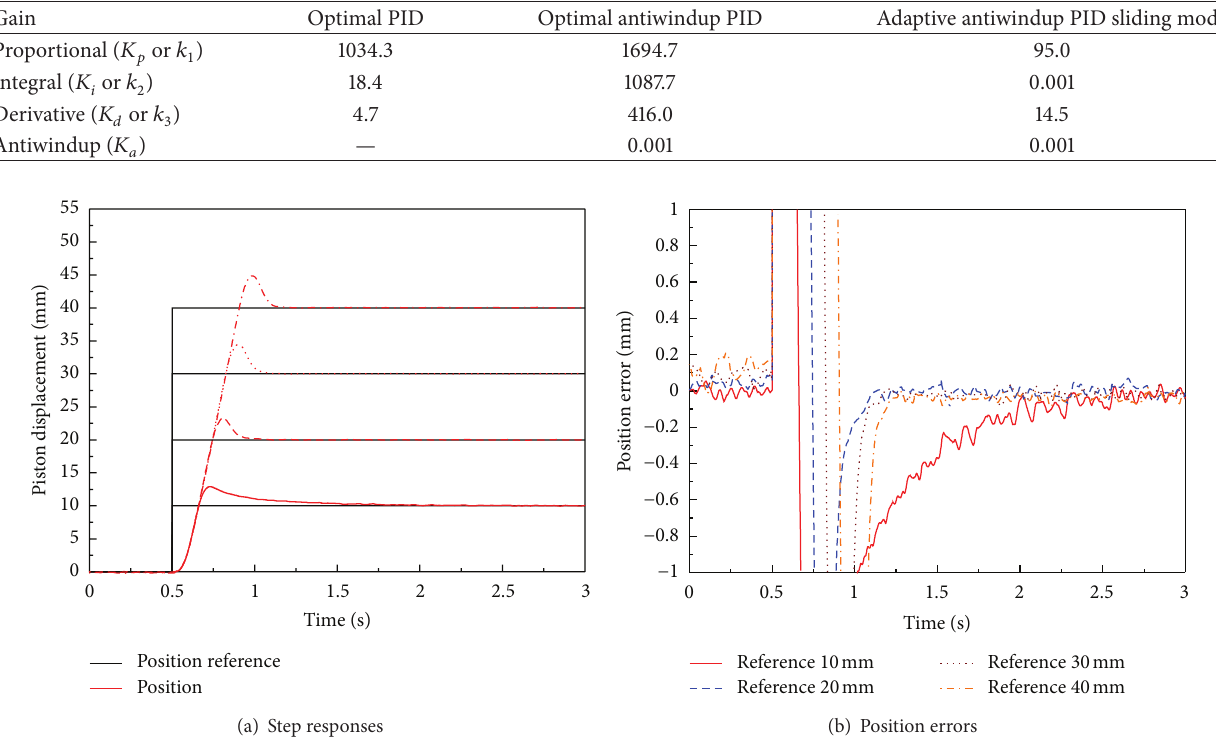
Table 3: Optimal gains of optimal PID, antiwindup PID, and adaptive anti-windup PID sliding mode control systems in experiments.